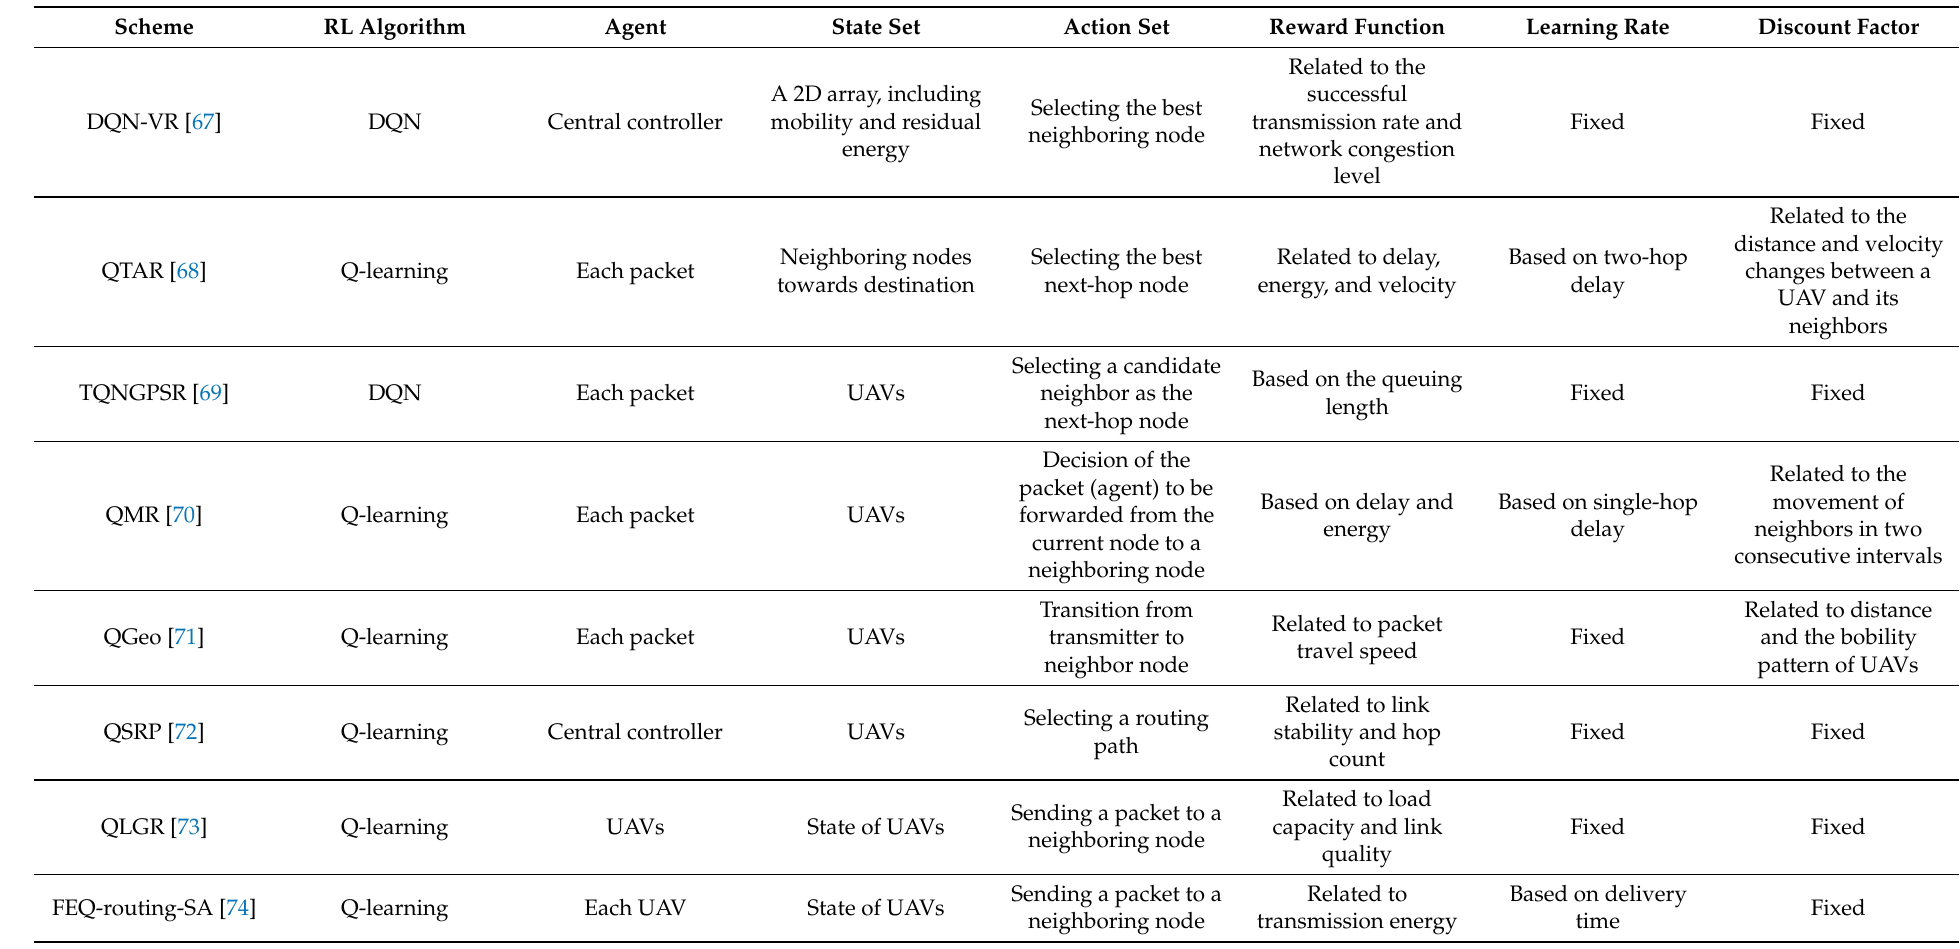
Table 26. Learning parameters in RL-based routing